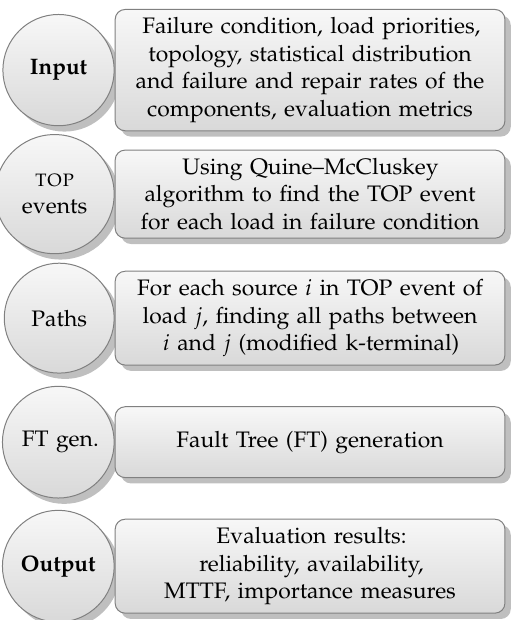
Figure 4. Overview of the methodology for dependability evaluation of smart